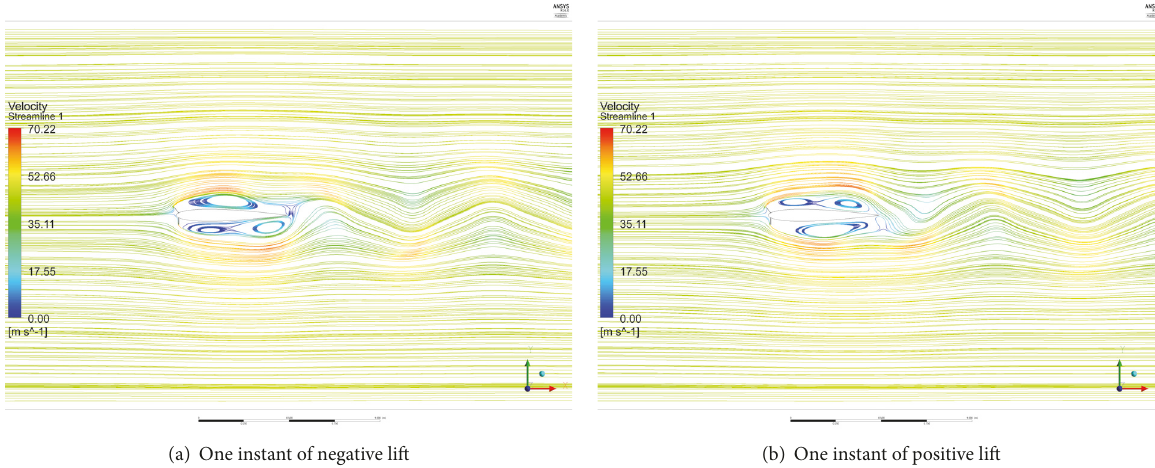
Figure 10: Vortices shape at two moments with an interval of half period at zero angle of attack.